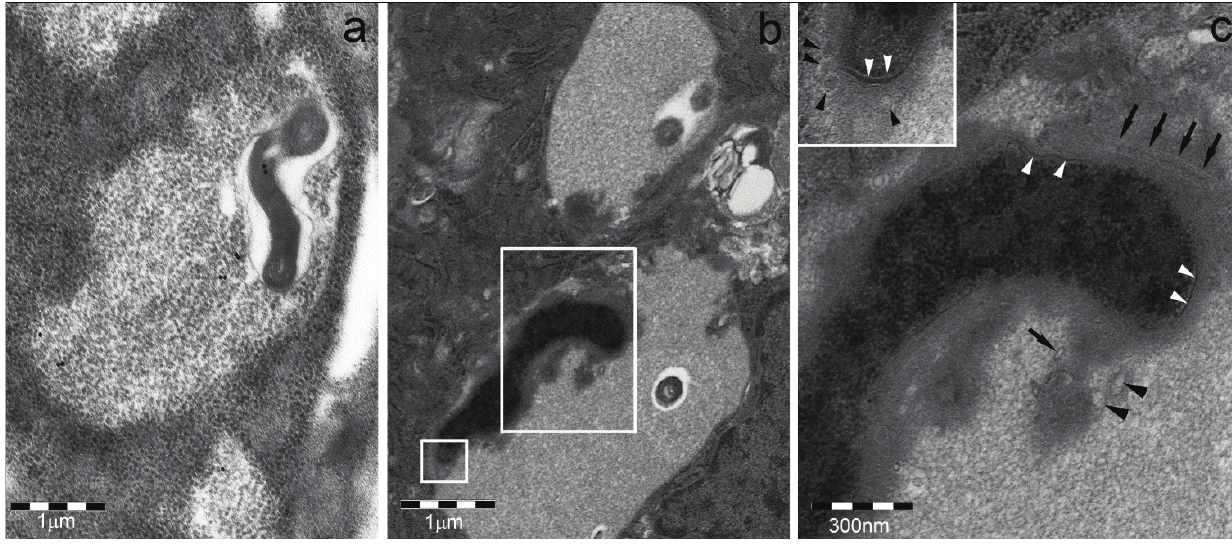
Figure 5. PaCS and infectious diseases. Electron microscopy of H. pylori colonized foveolar epithelium in a biopsy from human chronic gastritis (see [8] for more details). ( a ) A bacterium is shown inside PaCS; note the sparse CagA toxin immunogold reactivity of both the bacterium and its surrounding PaCS structure; ( b ) Longitudinally or cross-sectioned bacteria are found in two sequestosomes; the larger boxed area is enlarged in ( c ) and the smaller one in its inset to show partly preserved bacterial membrane and periplasmic space (white arrowheads) as well as flagella (arrows) and clubbed ends (black arrowheads); also note the poorly fibrillar, thinly granular content of the